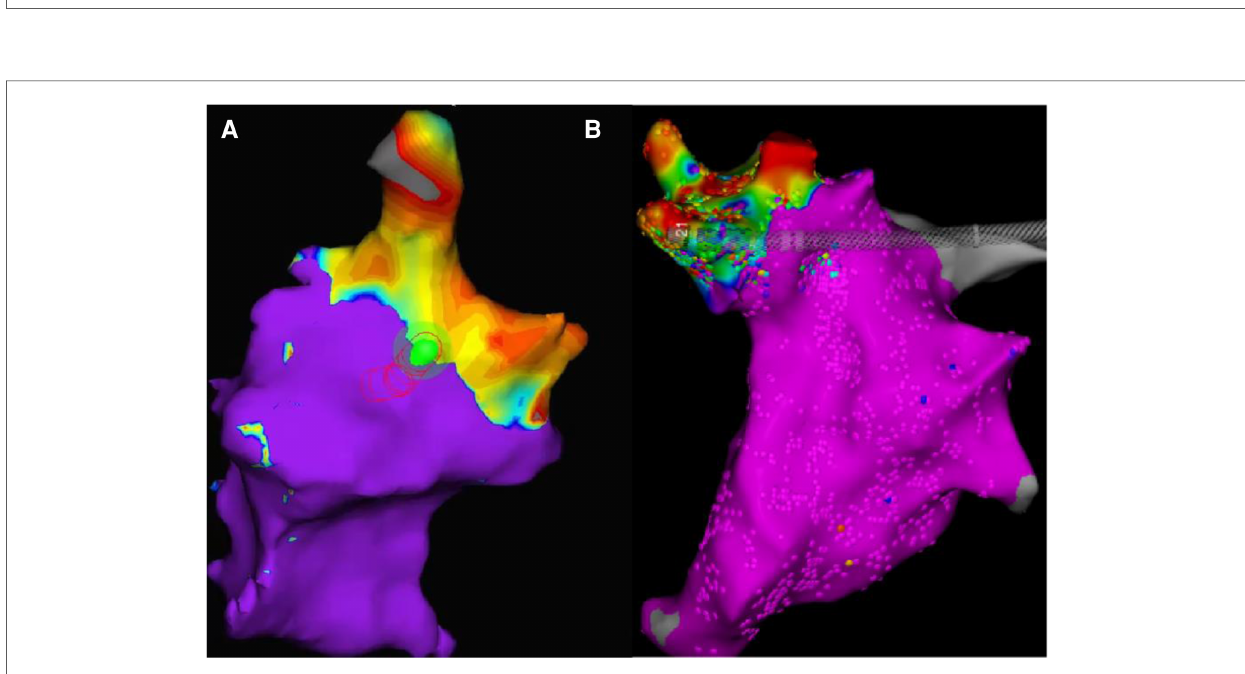
FIGURE 6 (results from dogB2, ablation site: right superior PV). The two maps have different color schemes due to the different systems used. The orientation and size of the pictures have been slightly adjusted for improved viewing, but the relative position and size remain unchanged. Map A displays the mapping results immediately after surgery, with the non-blue parts representing low voltage regions. Map B displays the mapping results 30 days after surgery, with the non-purple parts indicating low voltage